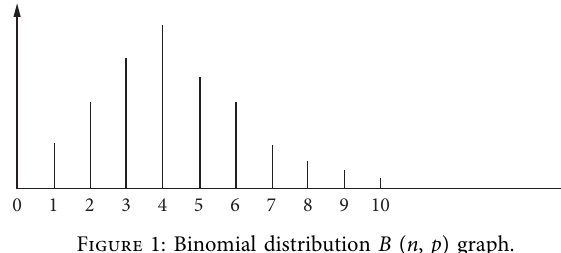
Figure 1: Binomial distribution B ( n , p )